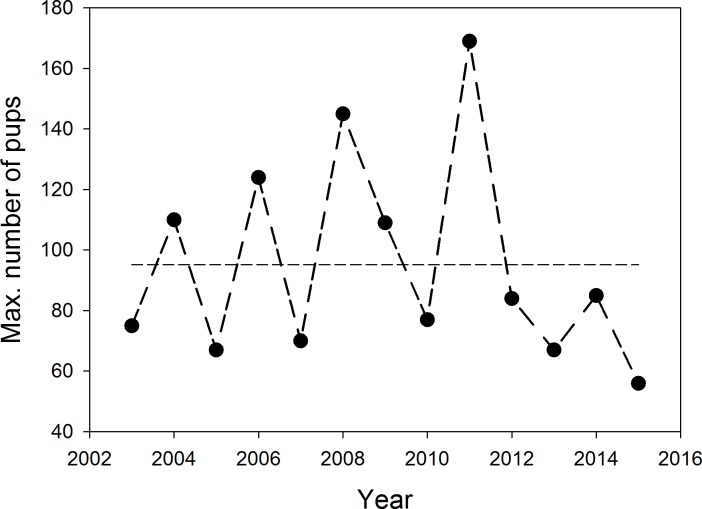
Total number of pups born in the study years as determined by marking of all newborn individuals.This number is greater than the numbers counted as shown in Fig 3B, since many pups die within the first month after birth and a single census rarely, if ever, records all pups present. Hatched line: 13-year mean of number of pups born. No recognizable overall trend exists in the numbers of pups born (linear regression; R2 = 0.0207; p = 0.639), even though pup numbers dropped over the last five years (2011–2015).